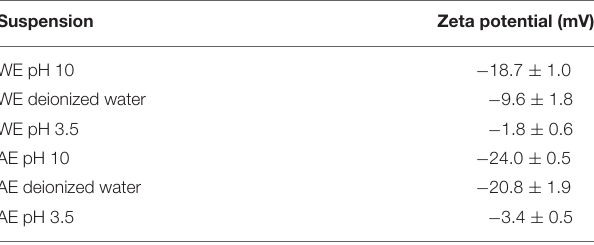
Presented values are mean and standard